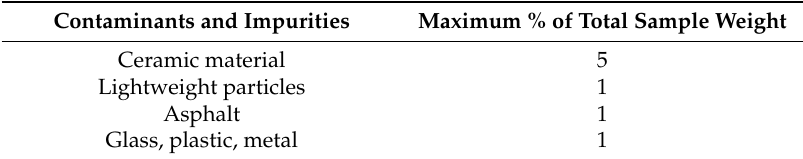
Table 1. Limitations on impurities in recycled aggregate.